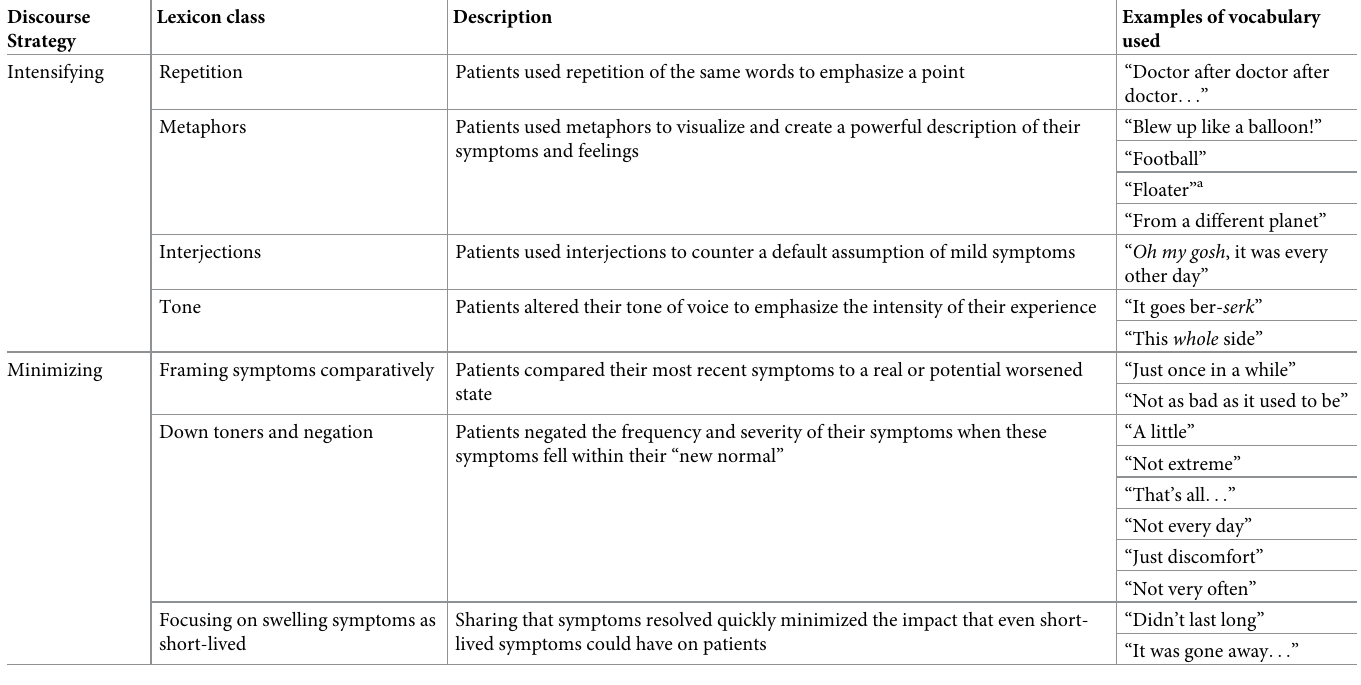
Table 3. Lexicon used by patients to describe